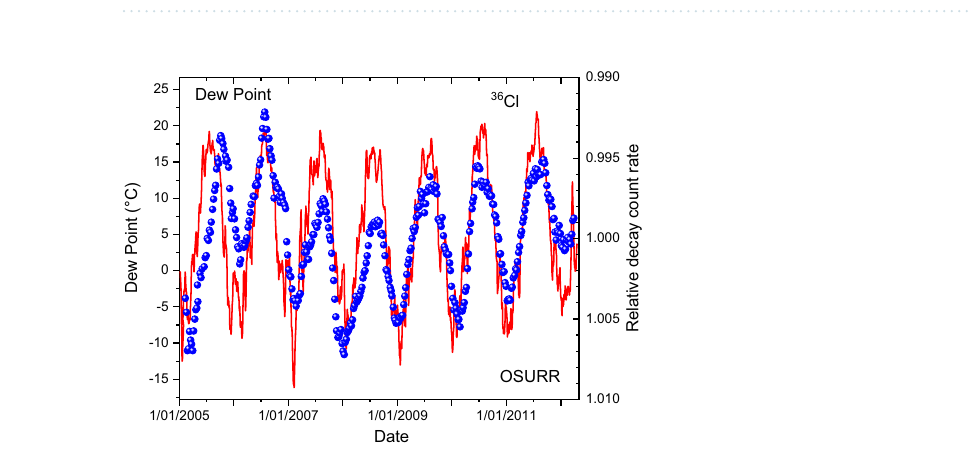
Figure 8. Relative deviations on measured decay rates of 36 Cl at OSURR (dots), compared to dew point data from a nearby weather station (line).